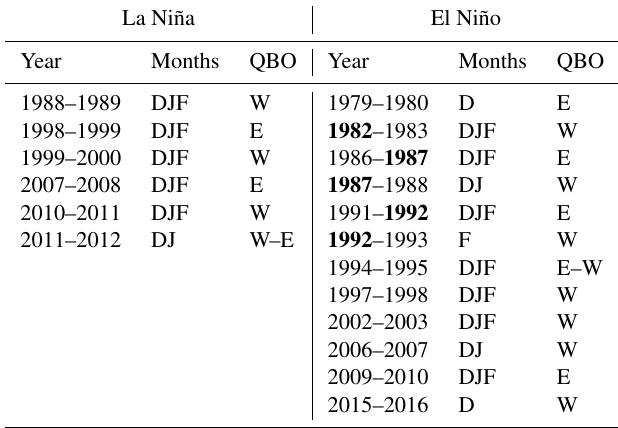
Table 1. List of all relevant La Niña and El Niño winter months during the period of 1979–2015. In total there are 17 and 28 months for the La Niña and El Niño composites, respectively, which are listed above (DJF for December, January and February). Within the La Niña composite there are 7 months in the easterly phase (E) and 10 months in the westerly phase (W) of the QBO (defined by 30-day smoothed equatorial wind at 50hPa). For El Niño composites 11 months are in the easterly phase and 17 months are in the westerly phase. The years in bold mark the long-lasting El Niño episodes (for details, see text). Table modified from Konopka et al.